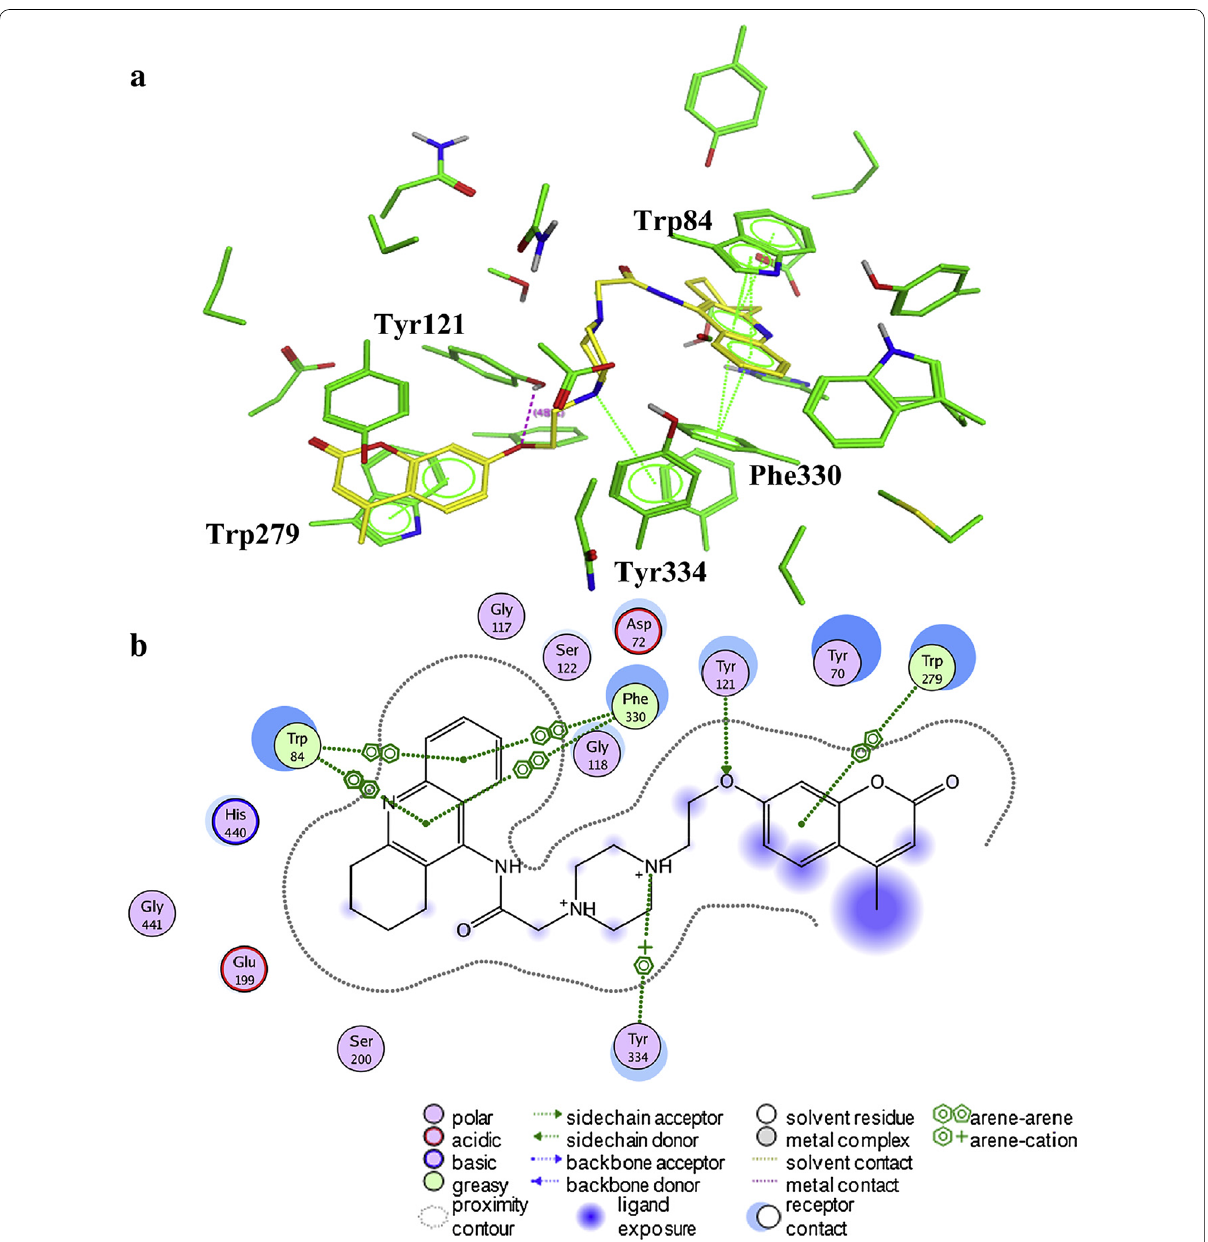
Fig. 80 3D docking model of C92 with TcAChE ( a , b )